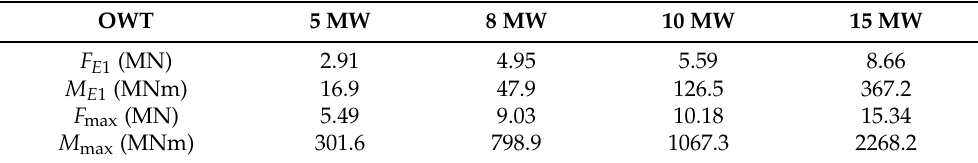
Table 5. Shear forces and bending moments obtained from the foundation design.